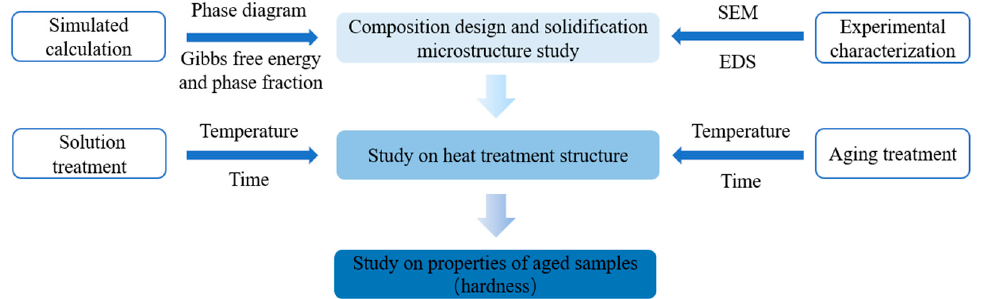
Figure 1. Schematic diagram of the overall research scheme.